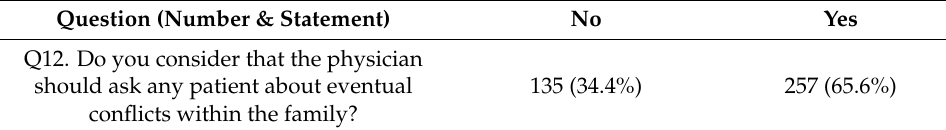
Table 3. Perception of the physician’s role in the context of the domestic violence